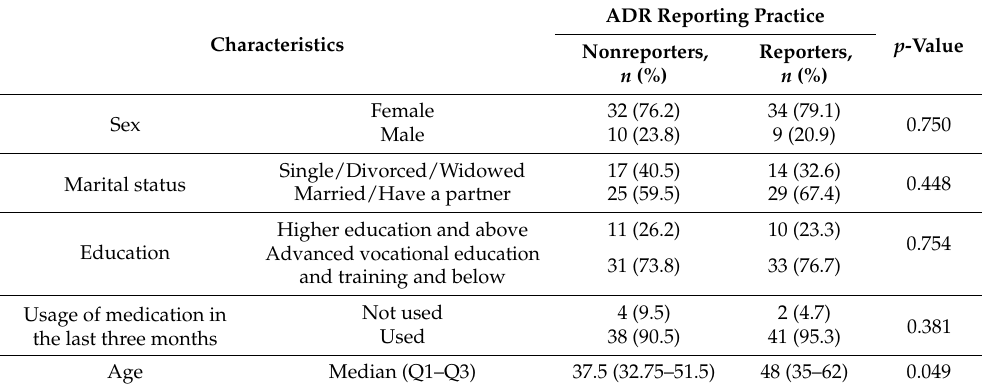
Table 5. Demographic characteristics of the consumers who experienced